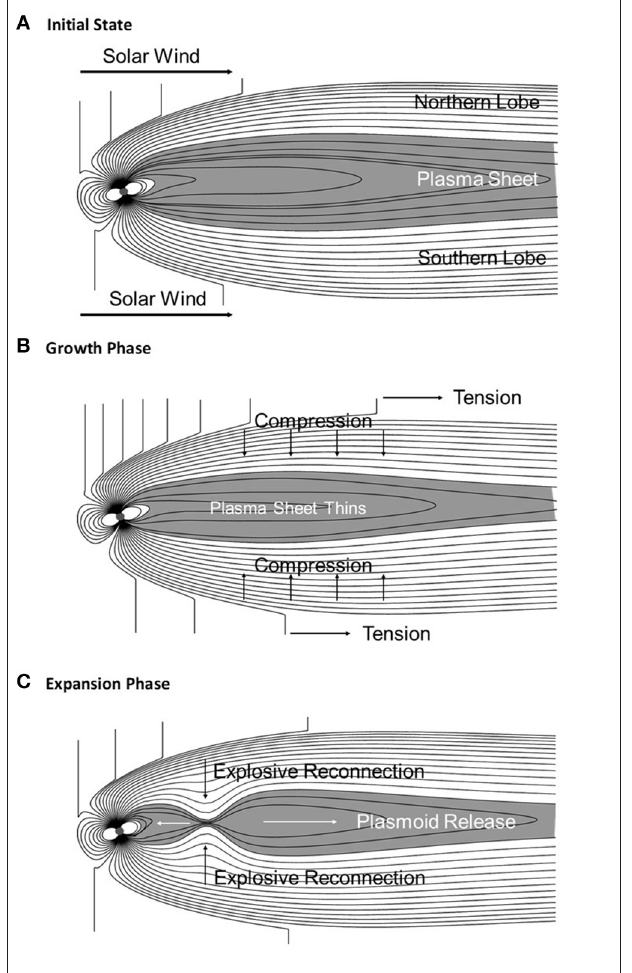
FIGURE 3 | Cross-sectional views of the Earth’s magnetosphere showing the solar wind interaction and dynamical evolution. (A) The quiet time or “ground state” configuration showing weak solar wind energy coupling to the magnetosphere. (B) The growth phase of the magnetospheric substorm showing increased solar wind energy coupling (due to dayside magnetic reconnection) and a plasma sheet thinning on the nightside. (C) Explosive reconnection at a near-Earth magnetic neutral line in the plasma sheet and plasmoid formation at substorm onset.